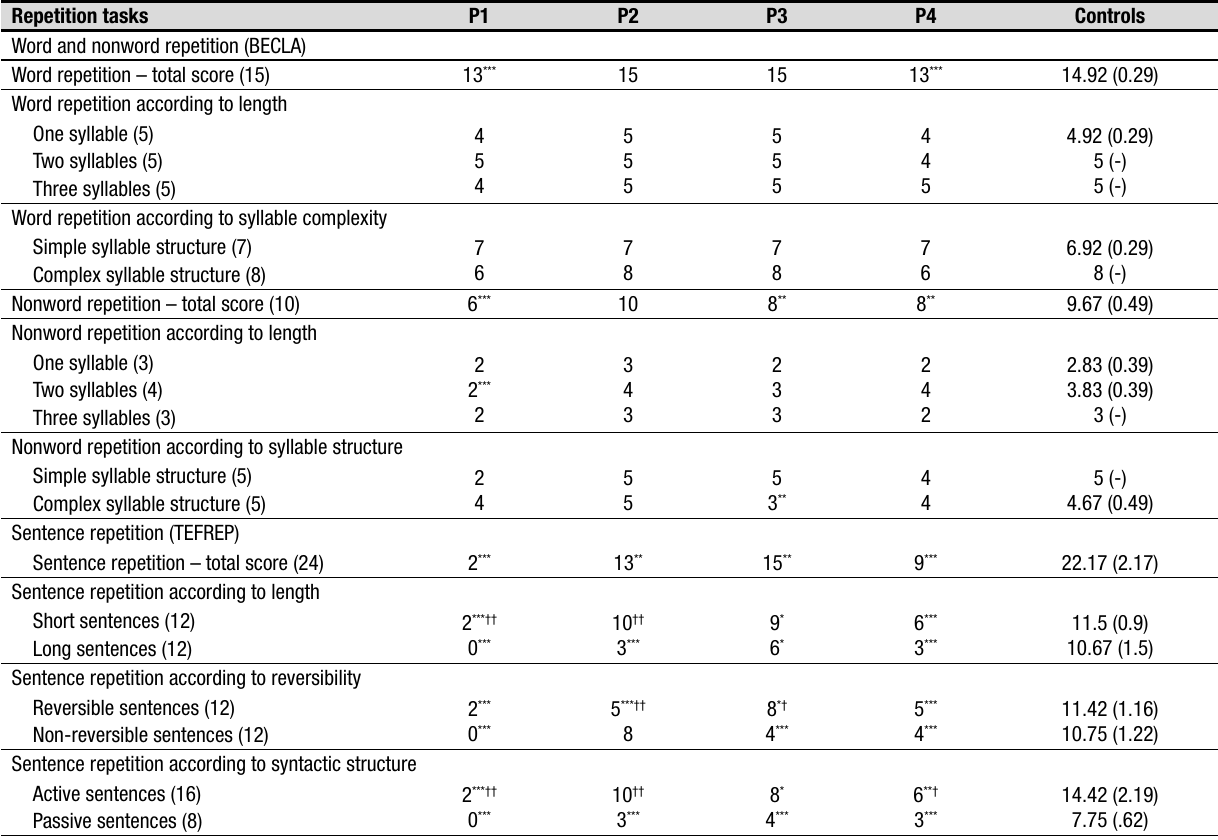
Table 3. Participants’ results on repetition tests.